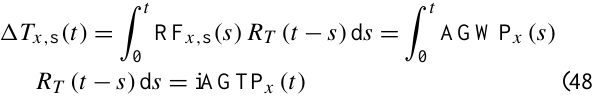
Further, the same is true for a linear temperature